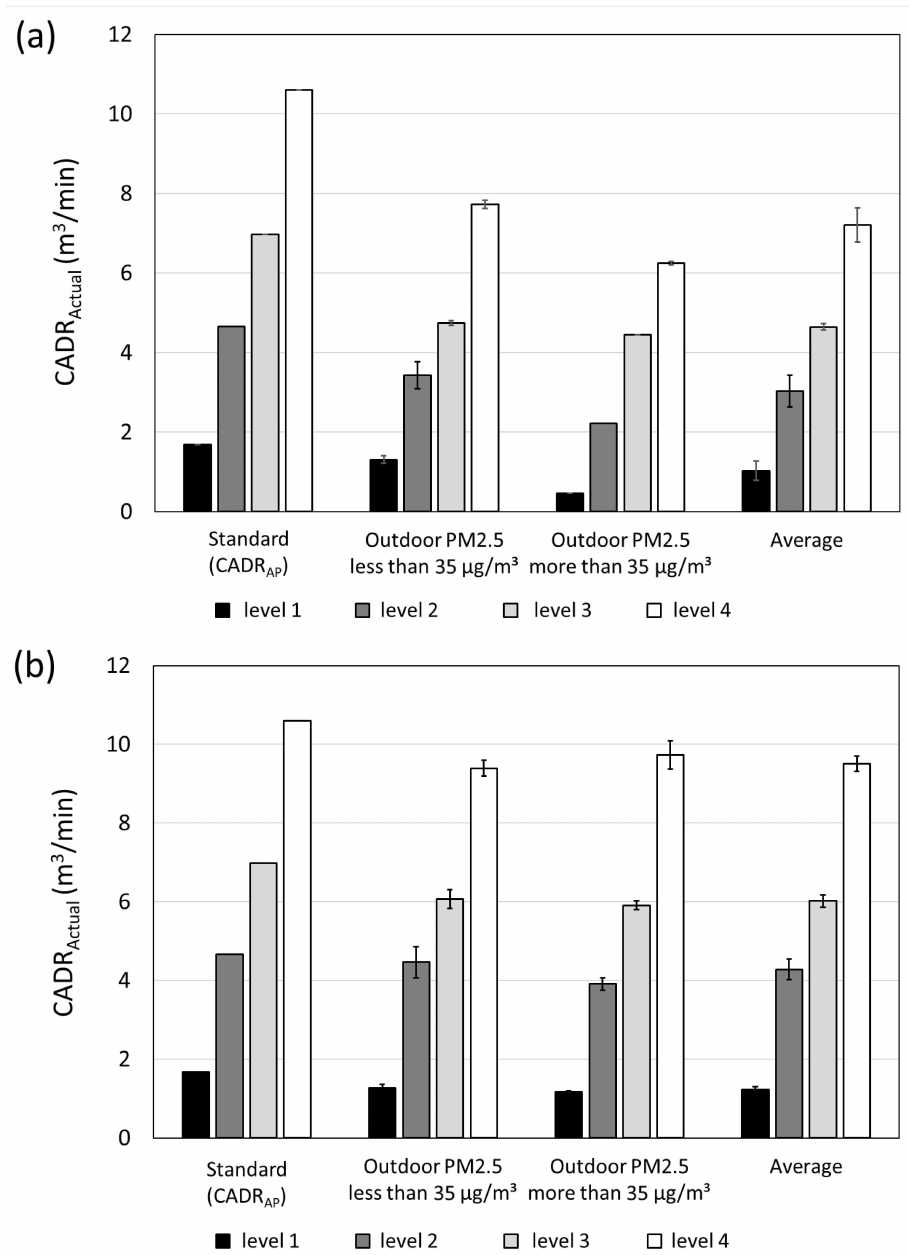
Figure 8. Comparison of CADR Actual to CADR AP (standard CADR) at ( a ) house A and ( b ) house B according to different outdoor PM 2.5 level